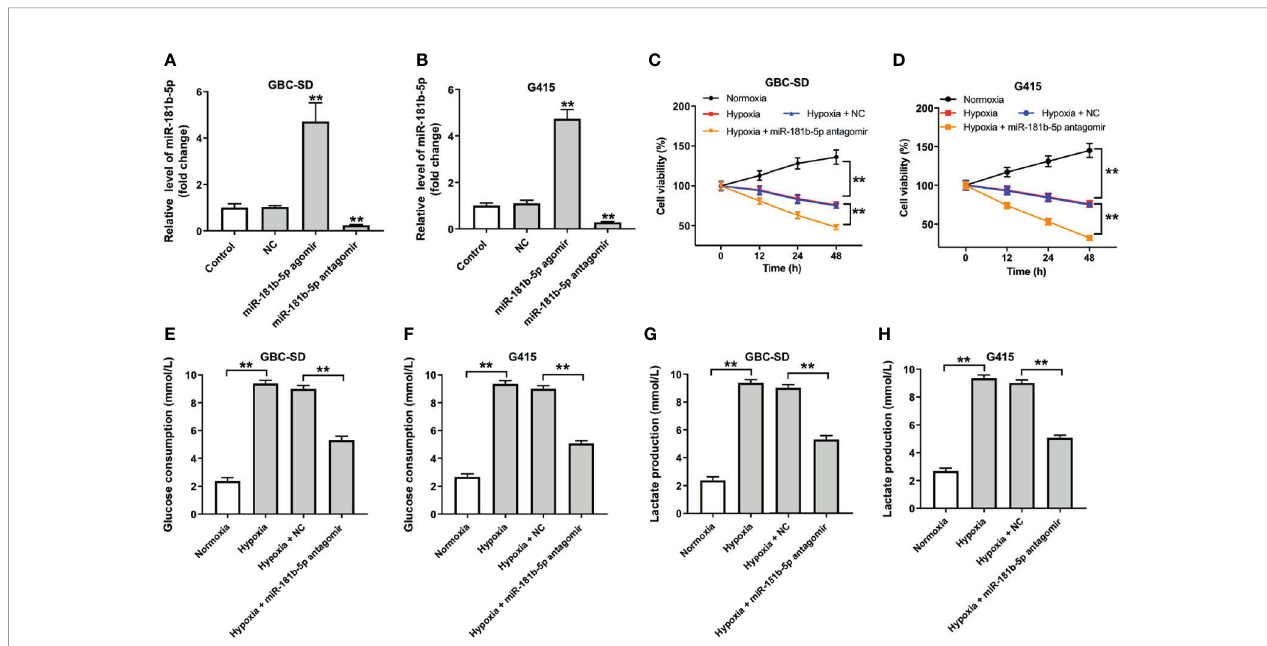
FIGURE 3 | Downregulation of miR-181b-5p inhibits cell viability and glycolysis in GBC under hypoxia. (A, B) GBC cells were transfected with miR-181b-5p agomir, antagomir, or negative control for 24 h RT-qPCR was performed to measure the level of miR-181b-5p in GBC-SD or in G415 cells. GBC cells were treated with hypoxia or hypoxia plus miR-181-5p antagomir (C, D) CCK-8 assay was used to detect GBC-SD or G415 cells viability. (E – H) Glucose Assay Kit or Lactic Acid assay kit was performed to detect the level of glucose consumption or lactate production in the cell supernatant. **P < 0.01 compared with control group, n =